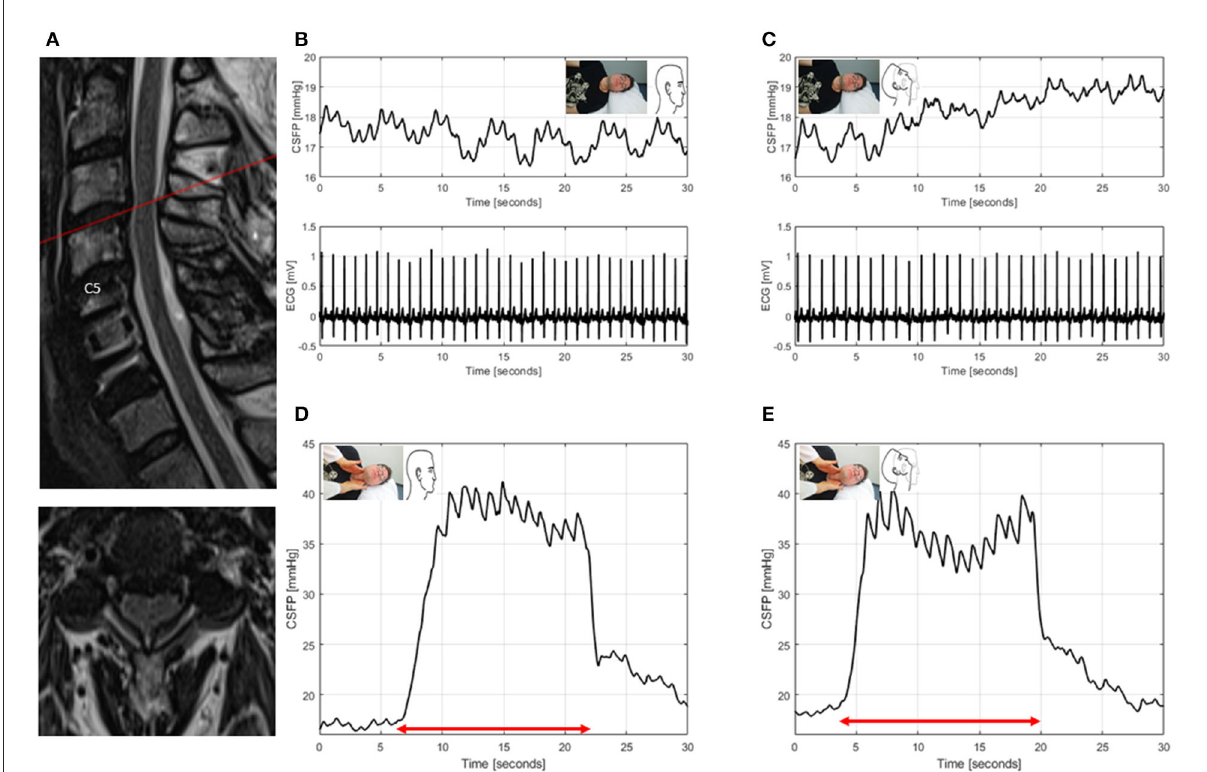
FIGURE6 T2-weighted MRI of the cervical spine for ID7 (patient with spinal canal stenosis of unknown significance, previously underwent surgery for degenerative cervical myelopathy, mJOA:9) (A) . Sagittal and axial images showing spinal canal narrowing with spinal cord induration at level C3/4. CSFP and electrocardiogram (ECG) are shown during resting state in neutral head position with baseline CSFP of 17.4 mmHg and cardiac-driven CSFP peak-to-trough amplitude (CSFPp) of 0.5 mmHg (B) , and in head reclination with baseline CSFP of 18.5 mmHg and CSFPp of 0.4 mmHg (C) . CSFP is plotted during the Queckenstedt’s test in neutral head position (rise, 17.7 mmHg) (D) , and in head reclination (rise, 18.7 mmHg) (E)